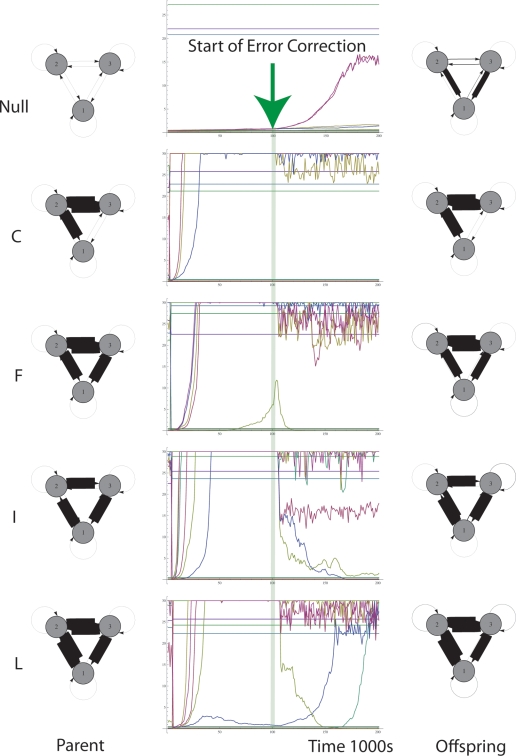
5 Motifs (Null, C,F, I & J) and their copying dynamics.Note that after error correction begins the weights change significantly. Note some zero weights in the parent stabilize at intermediate levels in the offspring. These intermediate level weights correspond to low probability of a pre-synaptic spike producing a post-synaptic spike. The tendency to produce these intermediate level weights can be tuned by adjusting the ratios of EC1 to EC2.